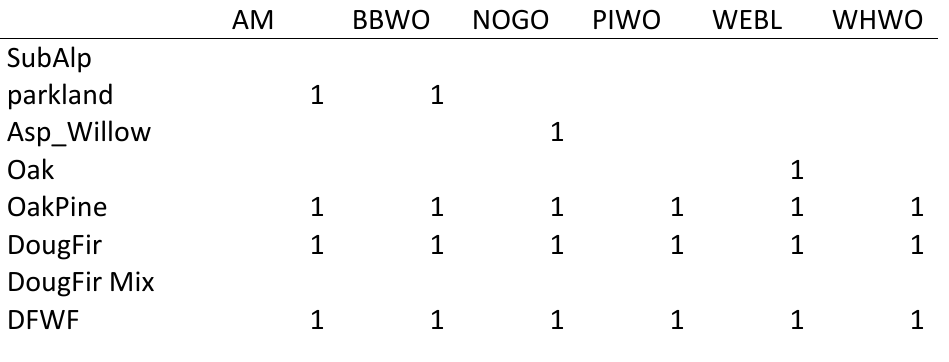
Table A8.5. Scores for species by cover type AM BBWO NOGO PIWO WEBL